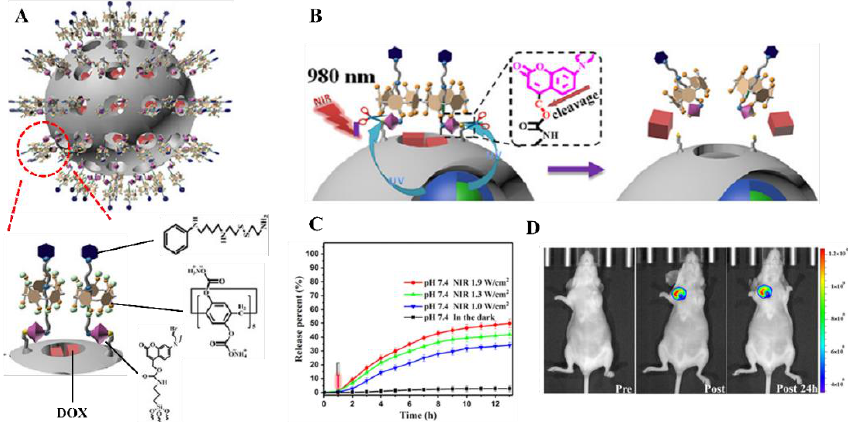
Figure 8. Schematic illustration of the NIR-triggered theranostic system and its effect on controlled release and image-guided diagnosis. ( A ) Structure of SiO 2 -coated upconversion (UC) nanostructures and the detailed structure of pore orifices anchored with supramolecular valves. ( B ) NIR-triggered release mechanism. ( C ) Doxorubicin (DOX) releasing profile under dark and different NIR irradiation dosages (1.0 – 1.9 W cm – 2 ). ( D ) In vivo UCL imaging of a tumor-bearing Balb/c mouse: pre-injection, post-injection and 24 h post-injection (from the left to the right). Reproduced with permission from [137].